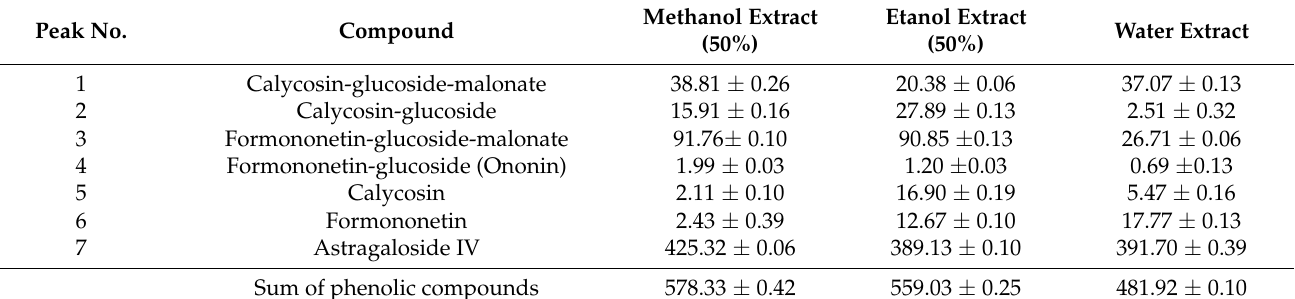
Table 4. Qualitative and quantitative analysis of the phenolic compounds found in the ASTRA root extracts by liquid chromatography expressed as µ g formononetin/g